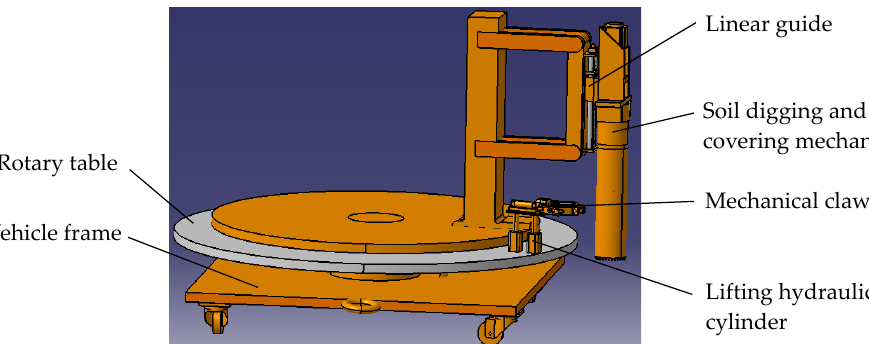
Figure 31. New tree-planting machine functional structure.